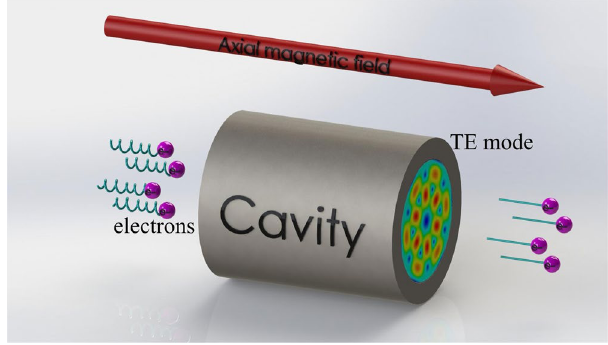
Figure 1. Beam–wave interaction in electron cyclotron